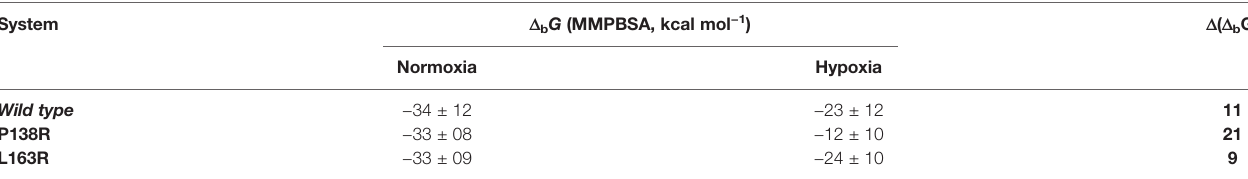
TABLE 2 | MMPB(GB)SA-binding free-energies ( D b G ) for VBC: HIF-1 a complexes.